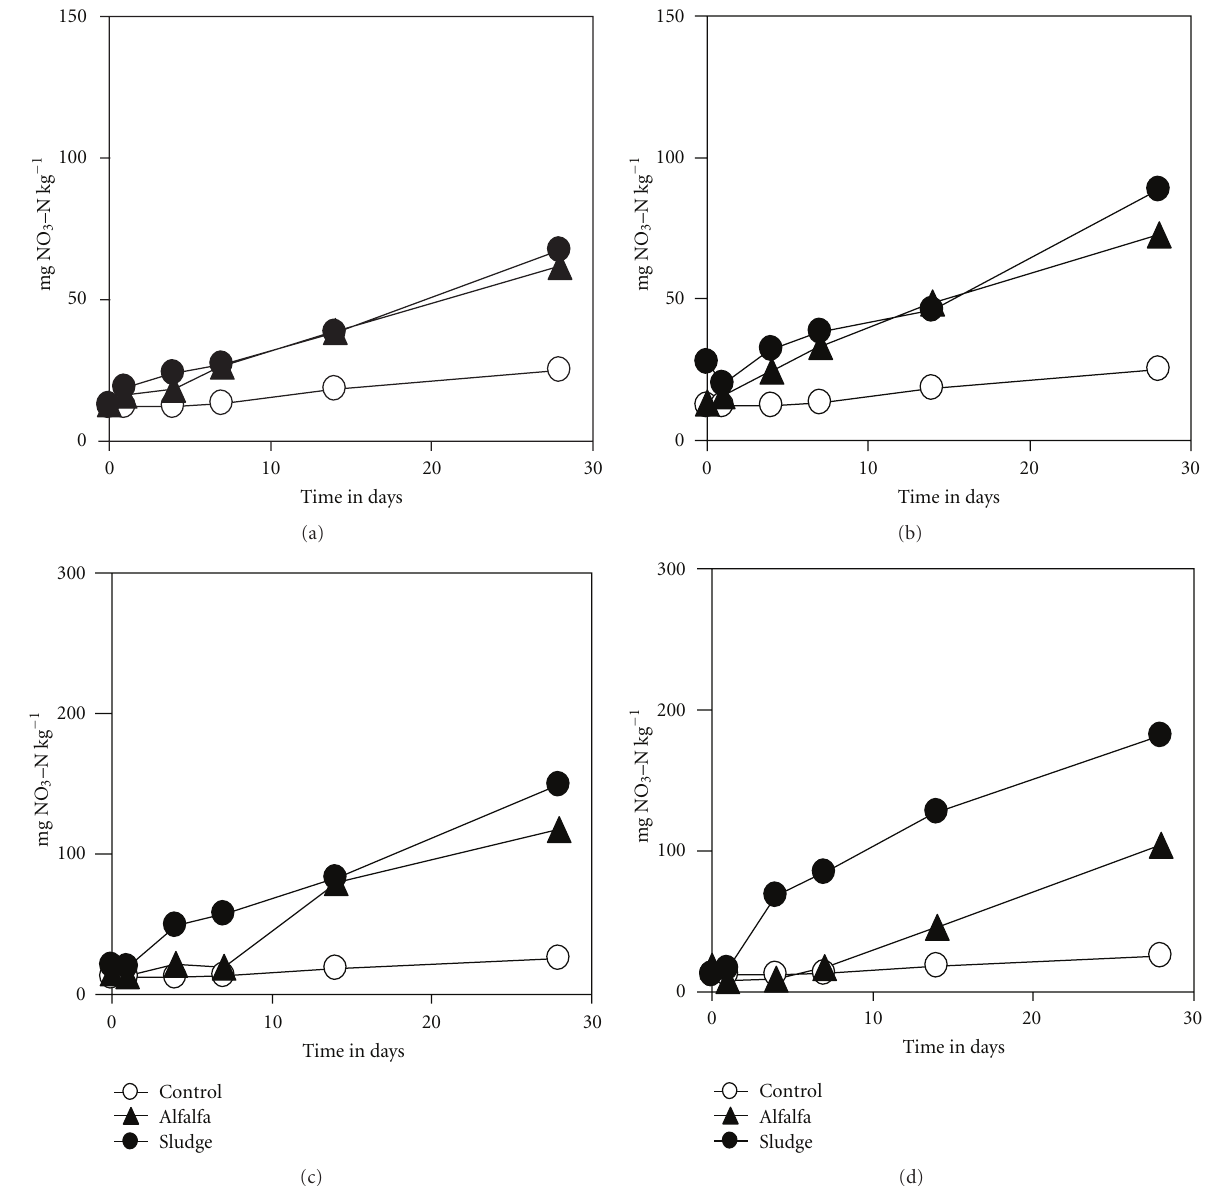
Figure 2: Incubation experiment one. Changes with time for nitrate extracted from incubations of sludge and alfalfa with soil at rates of (a) 100, (b) 200, (c) 400, and (d) 800mg Nkg − 1 dry soil. Controls received no